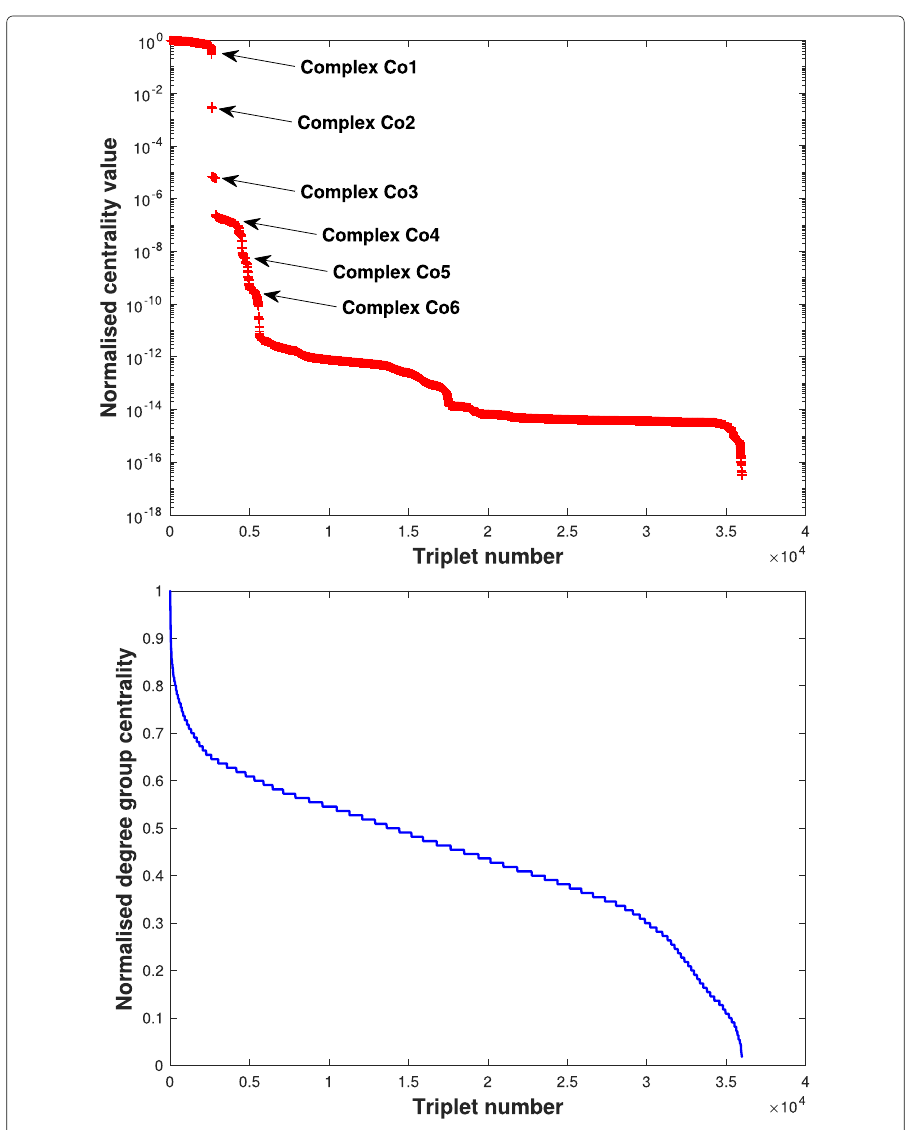
Fig. 2 Distributions of triplet centralities. Top: normalised triplet centralities c ( t )/ max t triplet ( c ( t ) ) , bottom: normalised degree group centrality g ( t )/ max t triplet ( g ( t )) introduced in (Everett and Borgatti